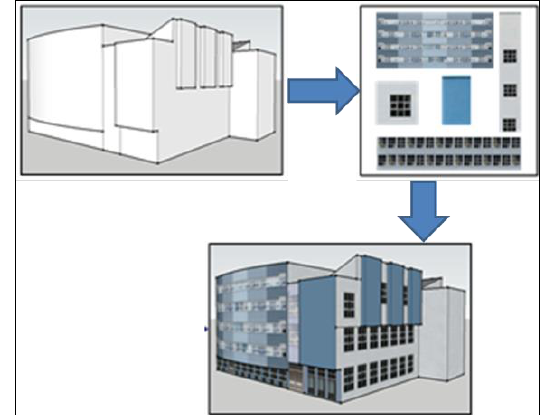
Figure 11: Texturing in 3D modeling